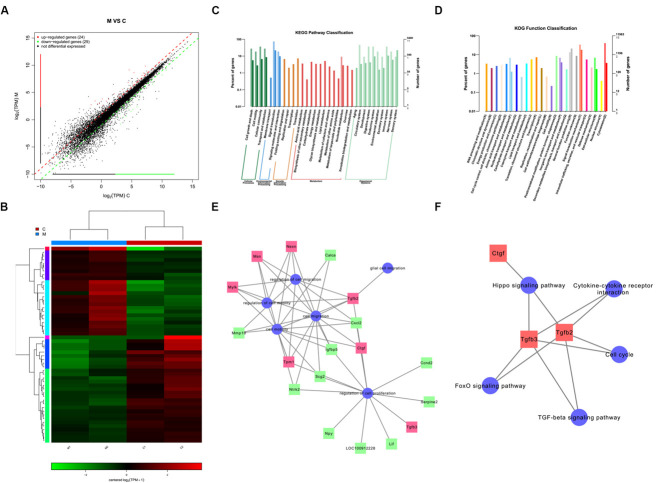
Analysis of genes and signaling pathways involved in Schwann cells (SCs) migration after overexpression of miR-124 according to RNA sequencing. (A) Scatter plot of differentially expressed genes. The horizontal and vertical axes are the two sets of sample log (TPM) values; each point in the figure represents a gene. Red, green, and black indicate the up-regulated, down-regulated, and non-differentiated genes, respectively. (B) Heatmap of differentially expressed genes. Red indicates higher gene expression level in the sample, whereas green indicates the opposite. The results showed the expression level and patterns of miR-124-SCs (M) significantly changed compared with the control group (C). (C) KEGG pathway classification. (D) KOG function classification. (E) GO map for genes enriched in cell motility and migration, as well as the regulation of these two processes and of cell proliferation and glial cell migration. (F) Pathway map for the potential molecular mechanisms and signaling pathways.